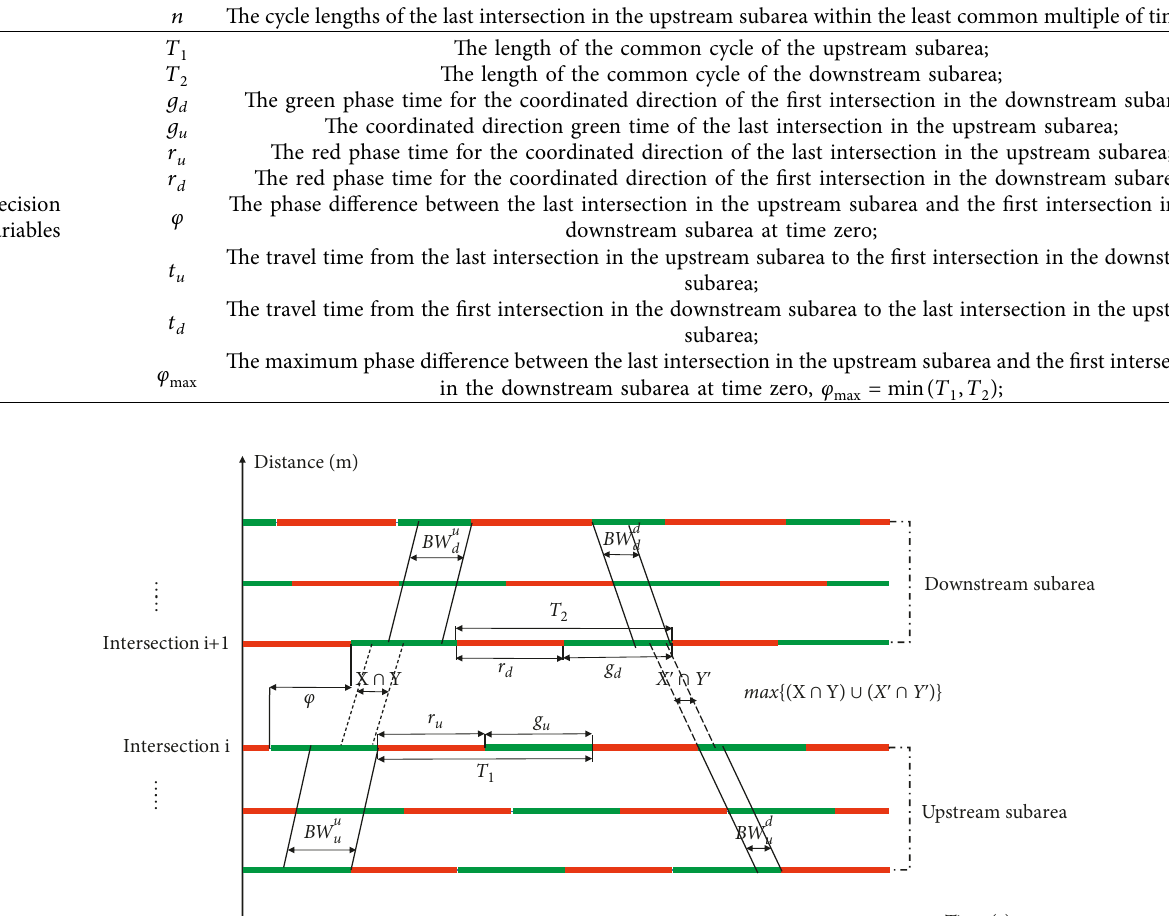
Figure 3: Schematic diagram of the coordination model of adjacent space